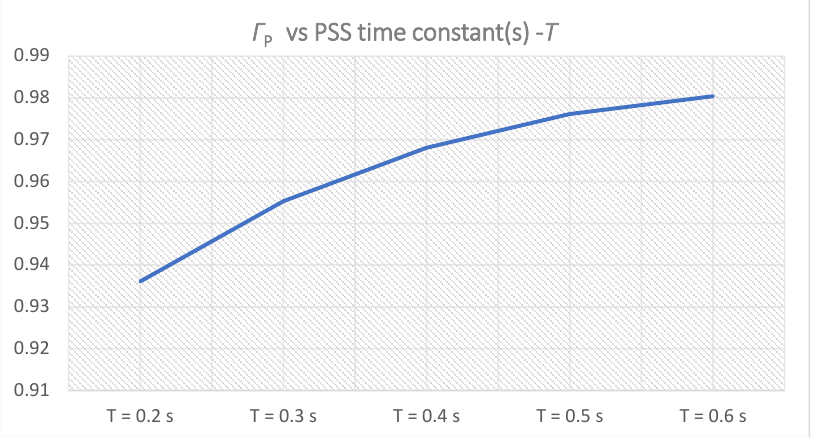
Figure 13. Γ Pi for PSS parameters K = 10, T = Ti, 1 = 0.2 – 0.6 s.